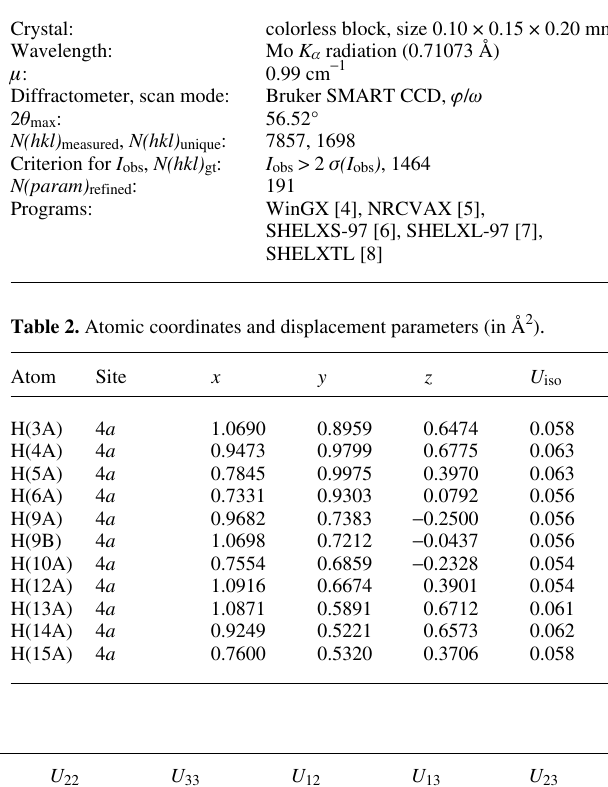
Table 1. Data collection and handling.